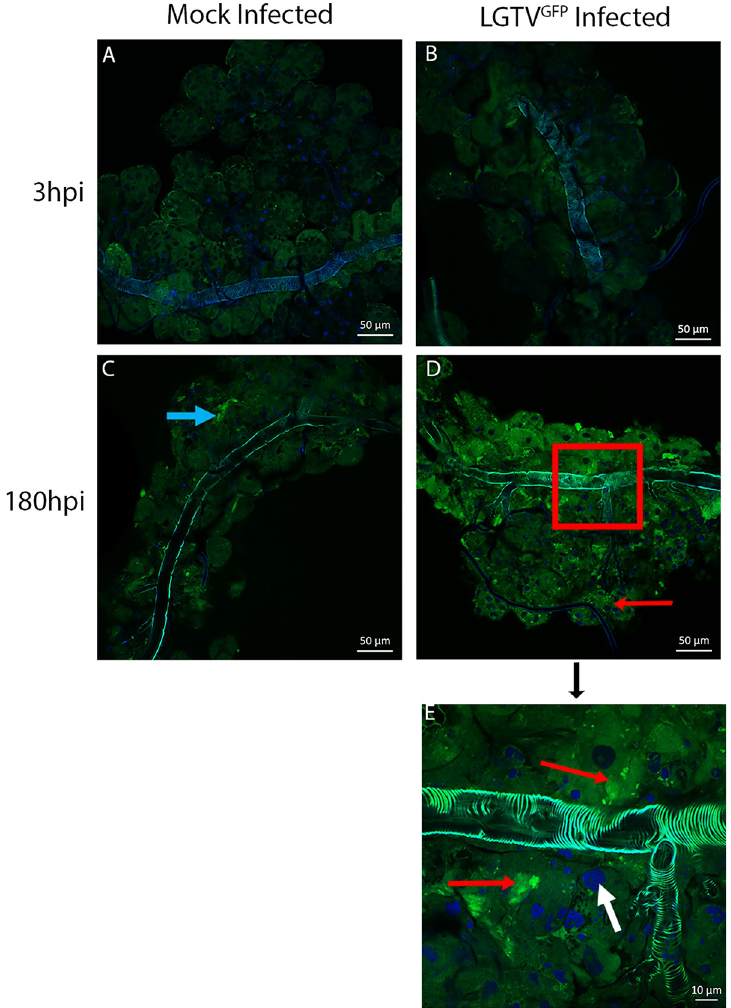
Fig 5. Localization of LGTV GFP in infected SG cultures from male ticks. Whole mounts of mock- and green fluorescent protein tagged-Langat virus (LGTV GFP )-infected salivary glands (SGs) from male Ixodes scapularis ticks were imaged via confocal microscopy. Each image displays a single SG from a pool of 3 SG pairs per experimental group. A-D images were taken at 40X and insert E was taken at 63X magnification, representing the portion of image D outlined with the red box. Image processing was consistent among respective timepoints. LGTV GFP -infected SGs shows both discrete puncta as well as broad aggregations of GFP expression in granular acini. Red arrows indicate LGTV GFP , blue arrows indicate autofluorescence, and white arrows indicate DAPI stained cell nuclei. Samples from mock-infected organs were shown in order to compare SG